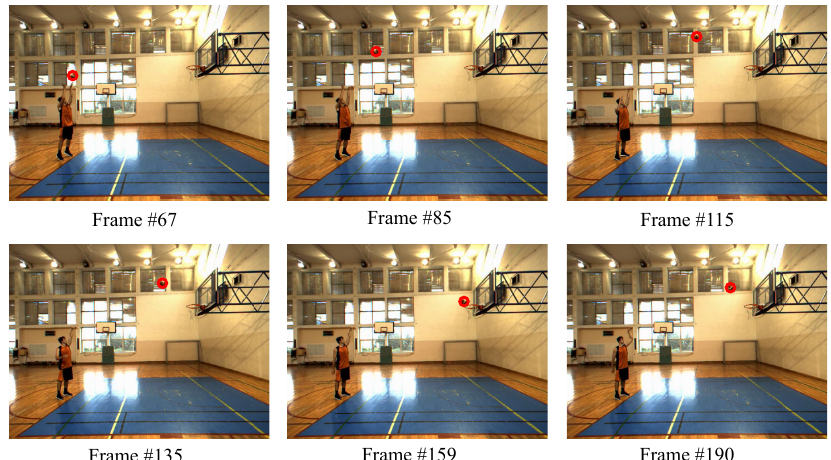
Figure 6. Ball tracking in selected frames of sequence